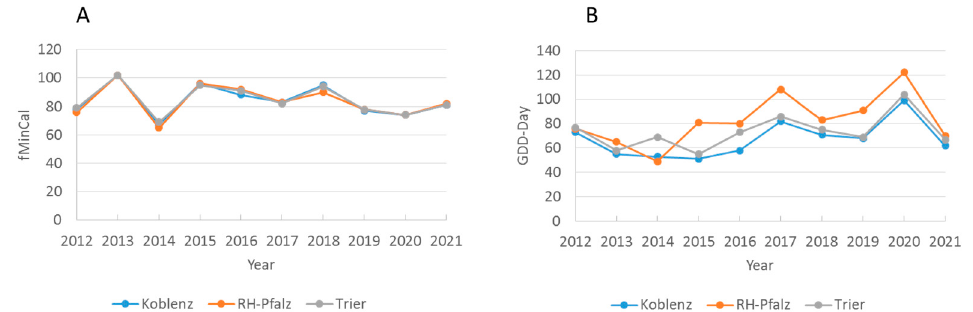
Figure 5. Start of honey flow and temperature sums of net cumulative honey flow in adjacent RP-regions, Koblenz, Rheinhessen-Pfalz (RH-Pfalz) and Trier 2012–2021. ( A ) Calendar day of first minimum cumulative weight (fMinCal), and ( B ) temperature sum on that day (GDD-day). The calendar day was constant among regions per year, whereas GDD-day differed significantly between regions (see text).